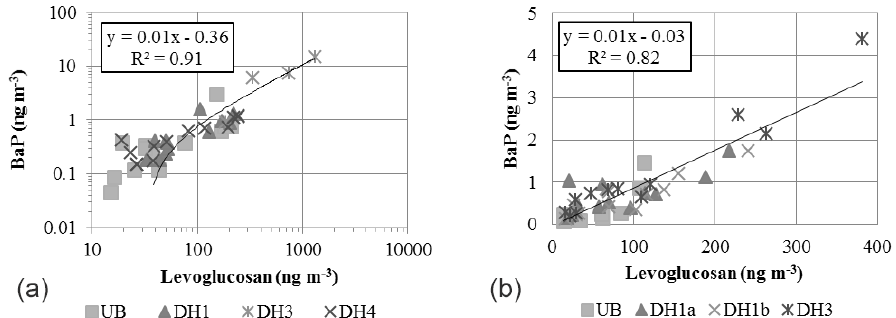
Figure 4. The linear correlation between BaP and levoglucosan concentrations in the urban background (UB) and suburban detached-house areas (DH) in Helsinki metropolitan area for (a) 24h means in February 2012 and for (b) monthly means in 2011. Panels (a) and (b) are presented on logarithmic and linear scales, respectively. The number of data points is 41 (panel a ) and 48 (panel b ).